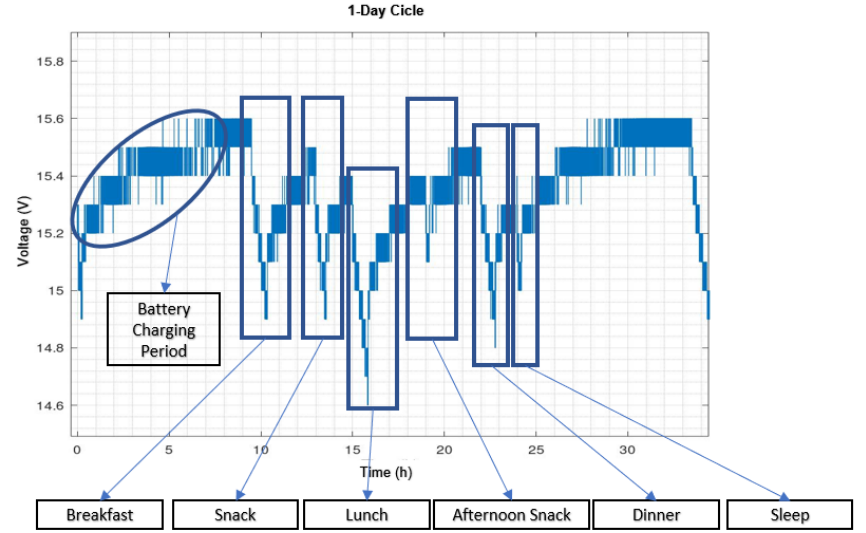
Figure 19. Battery charge and discharge profile for a normal operating day.